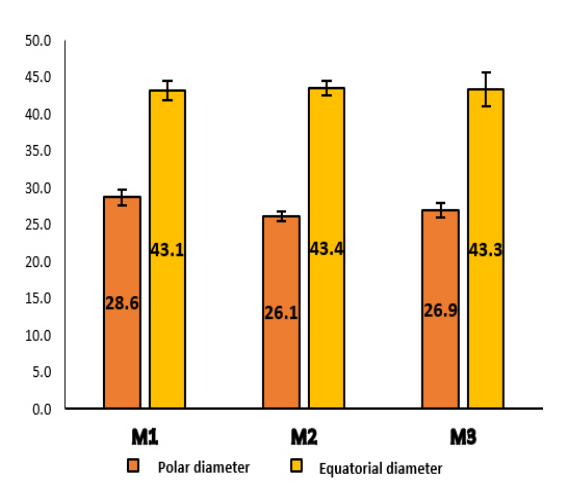
Figure 2. Effects of different methods of fertilisation on garlic bulb size (mm) in cv. ‘Cincomesino’. All the values are means ± SE (n = 10).